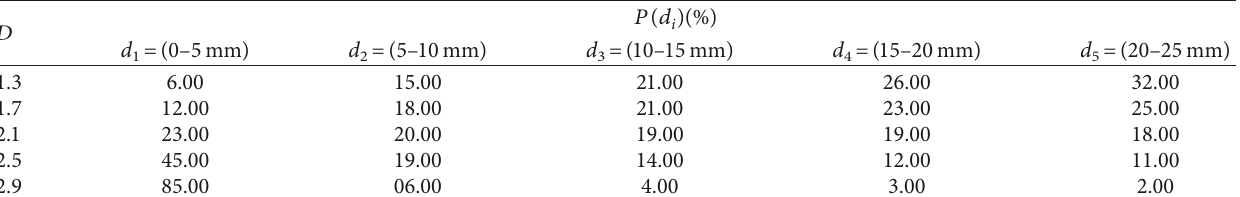
Table 1: Proportion of each component particle in different fractal dimensional gradation samples.